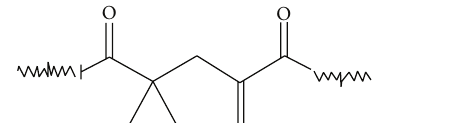
Figure 1: Generic depiction of Addition-Fragmentation Monomer (AFM) used in the experimental filling